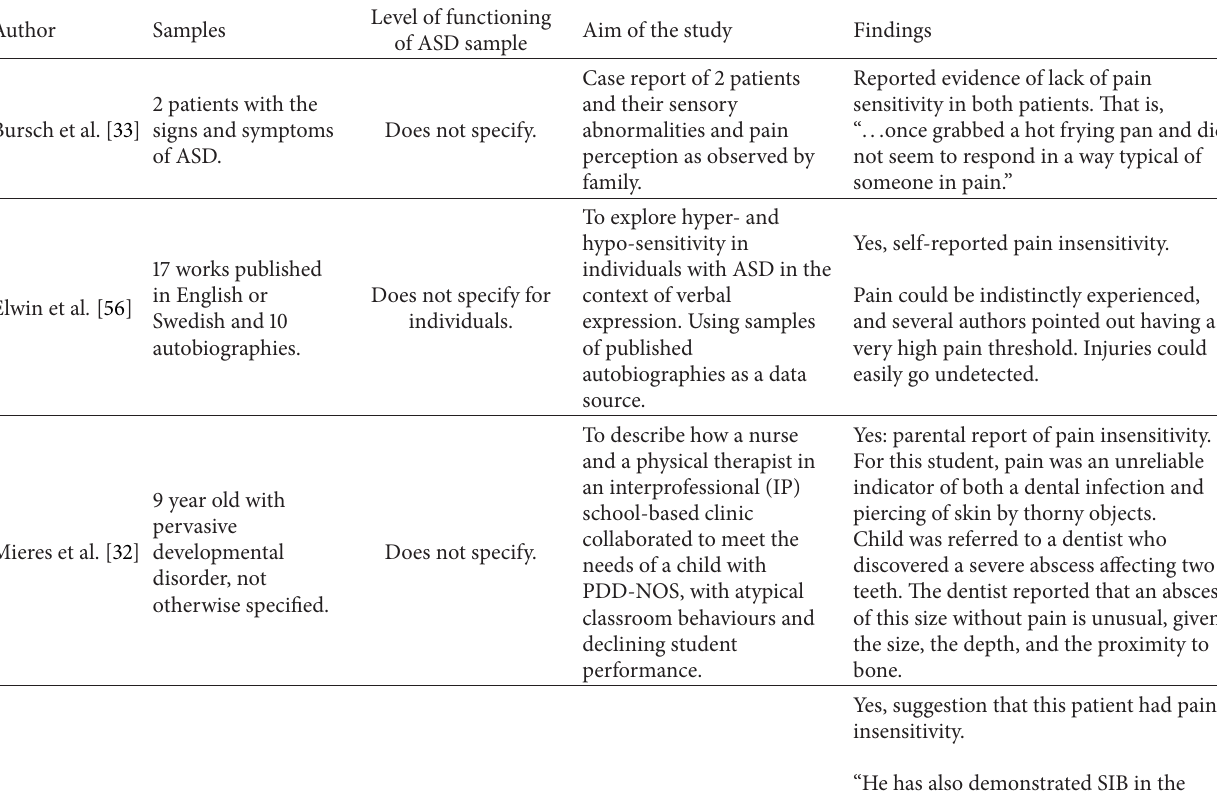
Table 1: Case report studies which explored pain perception, expression, or observer perception of pain in individuals with